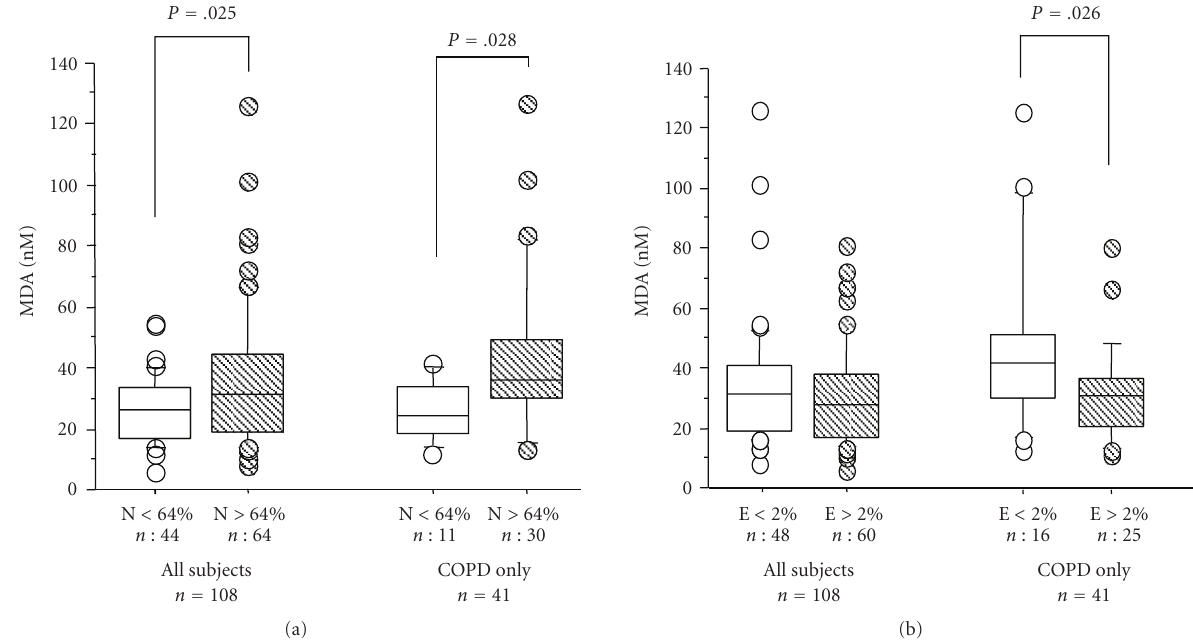
Figure 5: Median values (interquartile range) of malondialdehyde (MDA) in EBC according to induced sputum percentage of neutrophils (N%) (a) and eosinophils (E%) (b) in all patients and in COPD patients only. COPD: chronic obstructive pulmonary